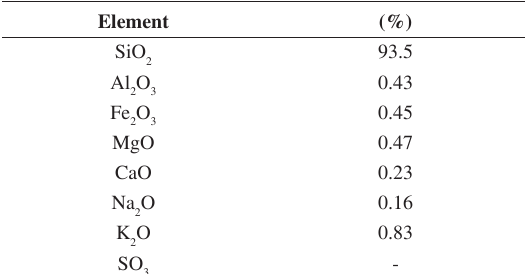
Table 6. Chemical analysis of silica